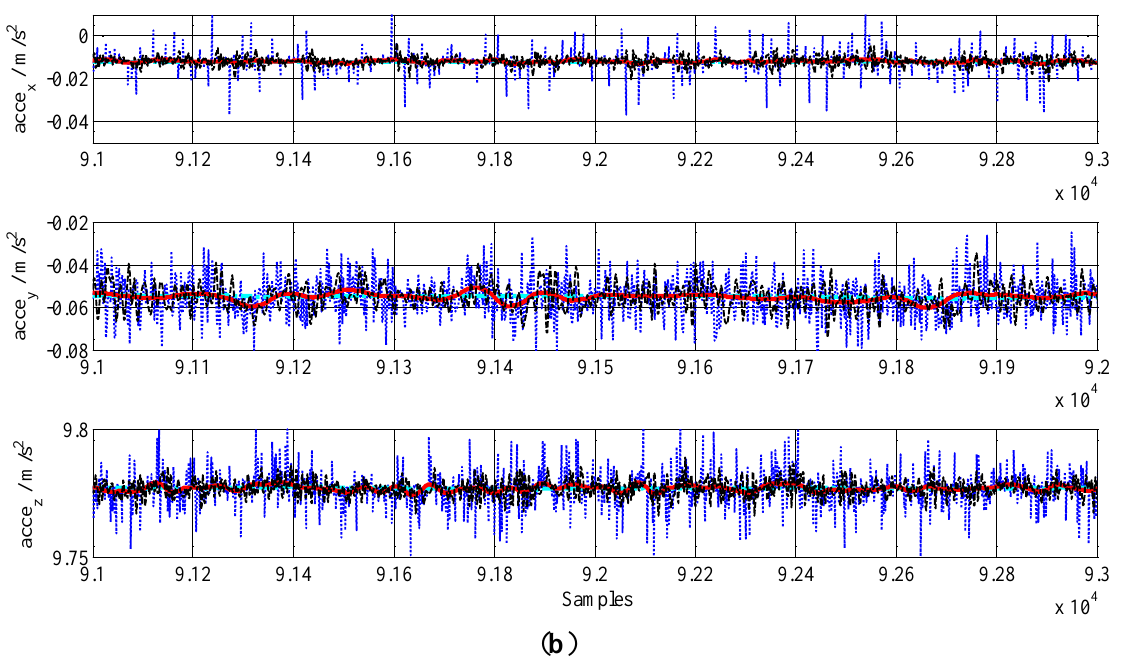
Figure 8. IMU dates in static ( a ) gyro dates ( b ) accelerometer